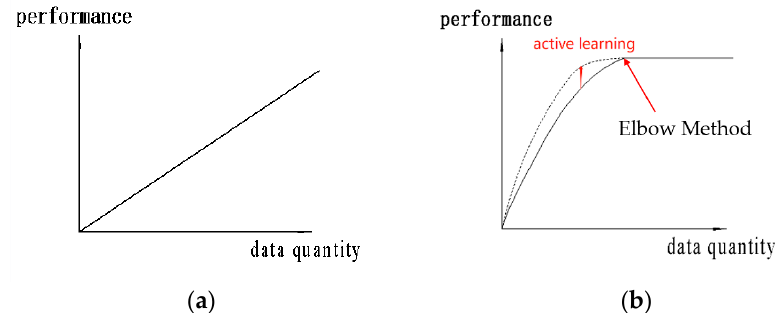
Figure 5. The performance of the model based on statistical characteristics increases linearly with the increase of data ( a ). When the data volume reaches a certain quantity the performance of the deep learning model, of which data sensitivity will reach a bottleneck and will not obviously increase with the increase of training data ( b ).